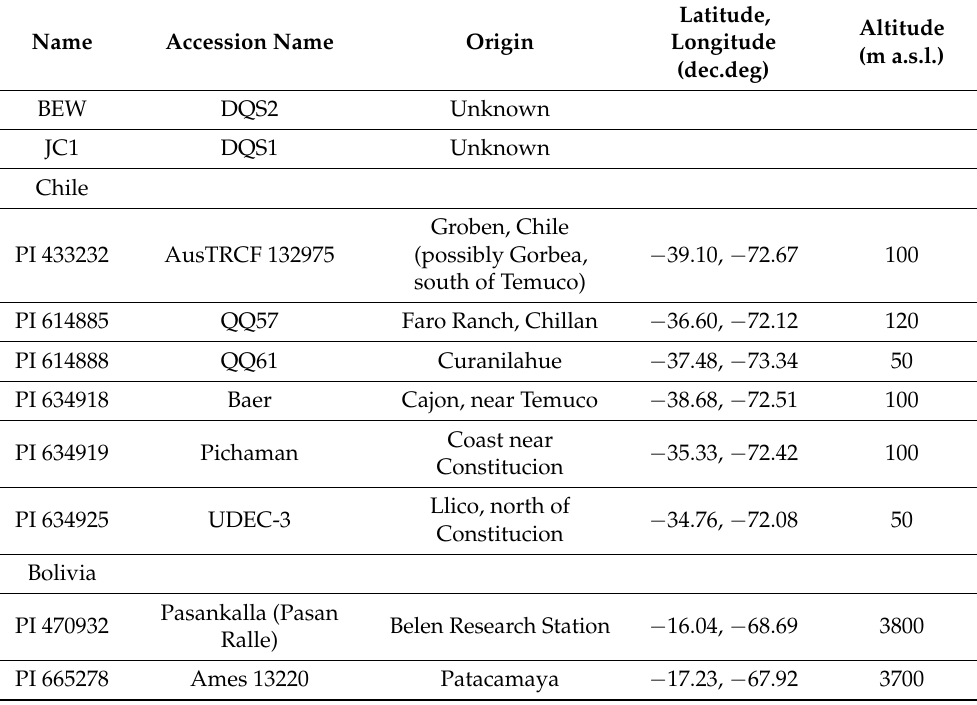
Table 1. Origin of two varieties and eight germplasm lines (accessions) used in field trials.